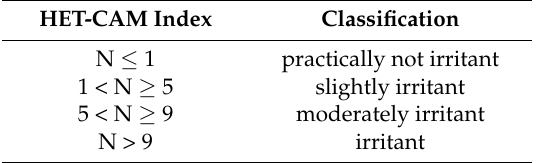
Table 2. Classification of products according to the scores of the